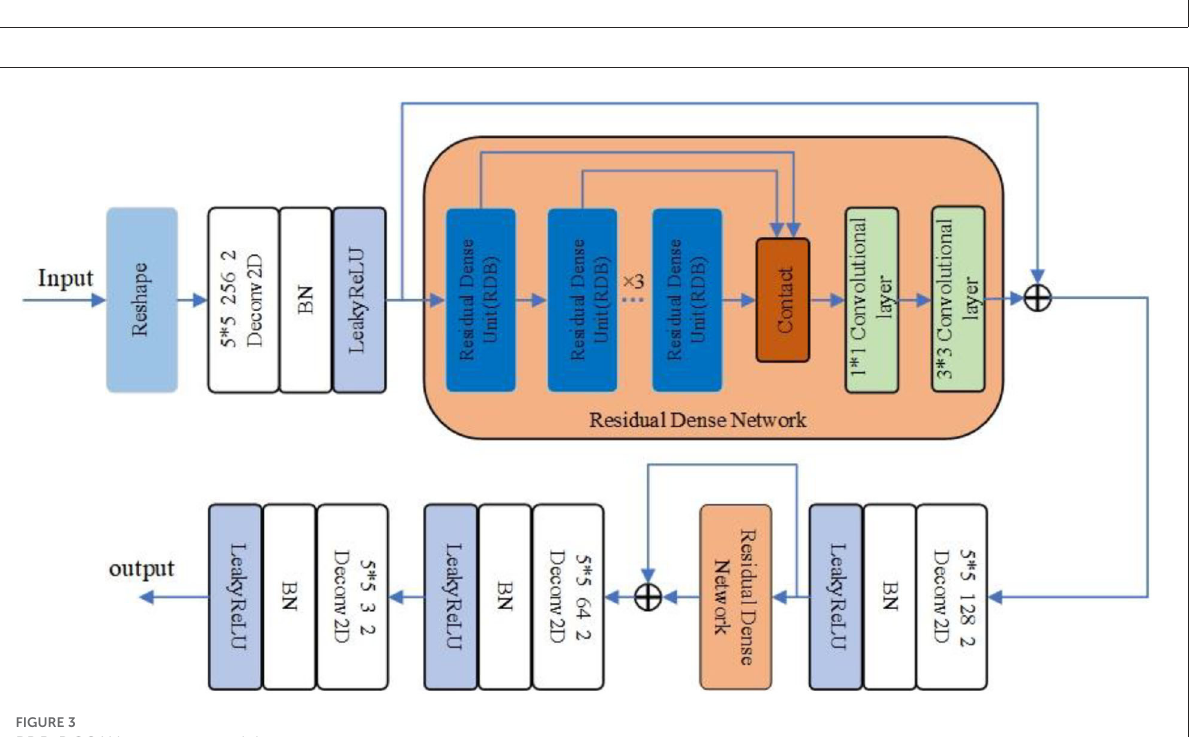
FIGURE2 The general framework of the model.